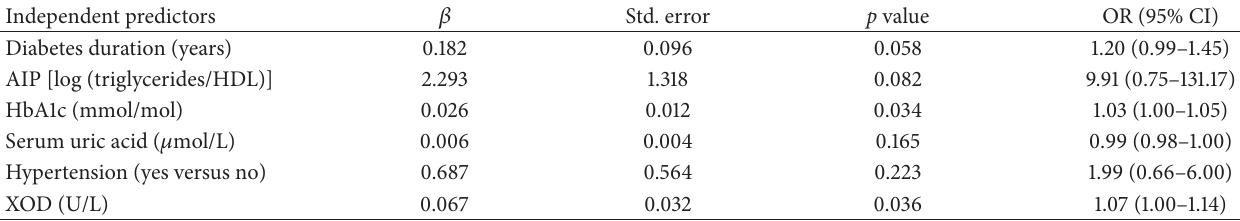
Table 4: Multivariable logistic regression analysis for association with diabetic peripheral